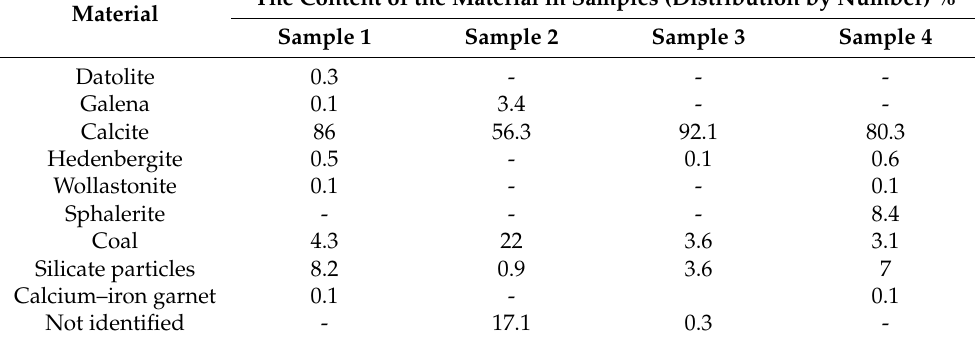
Table 3. Software chemical correlation based on Raman spectra of particles (5–25 µ m; n = 600 particles in each sample) in the samples of washout from conifer needles with material